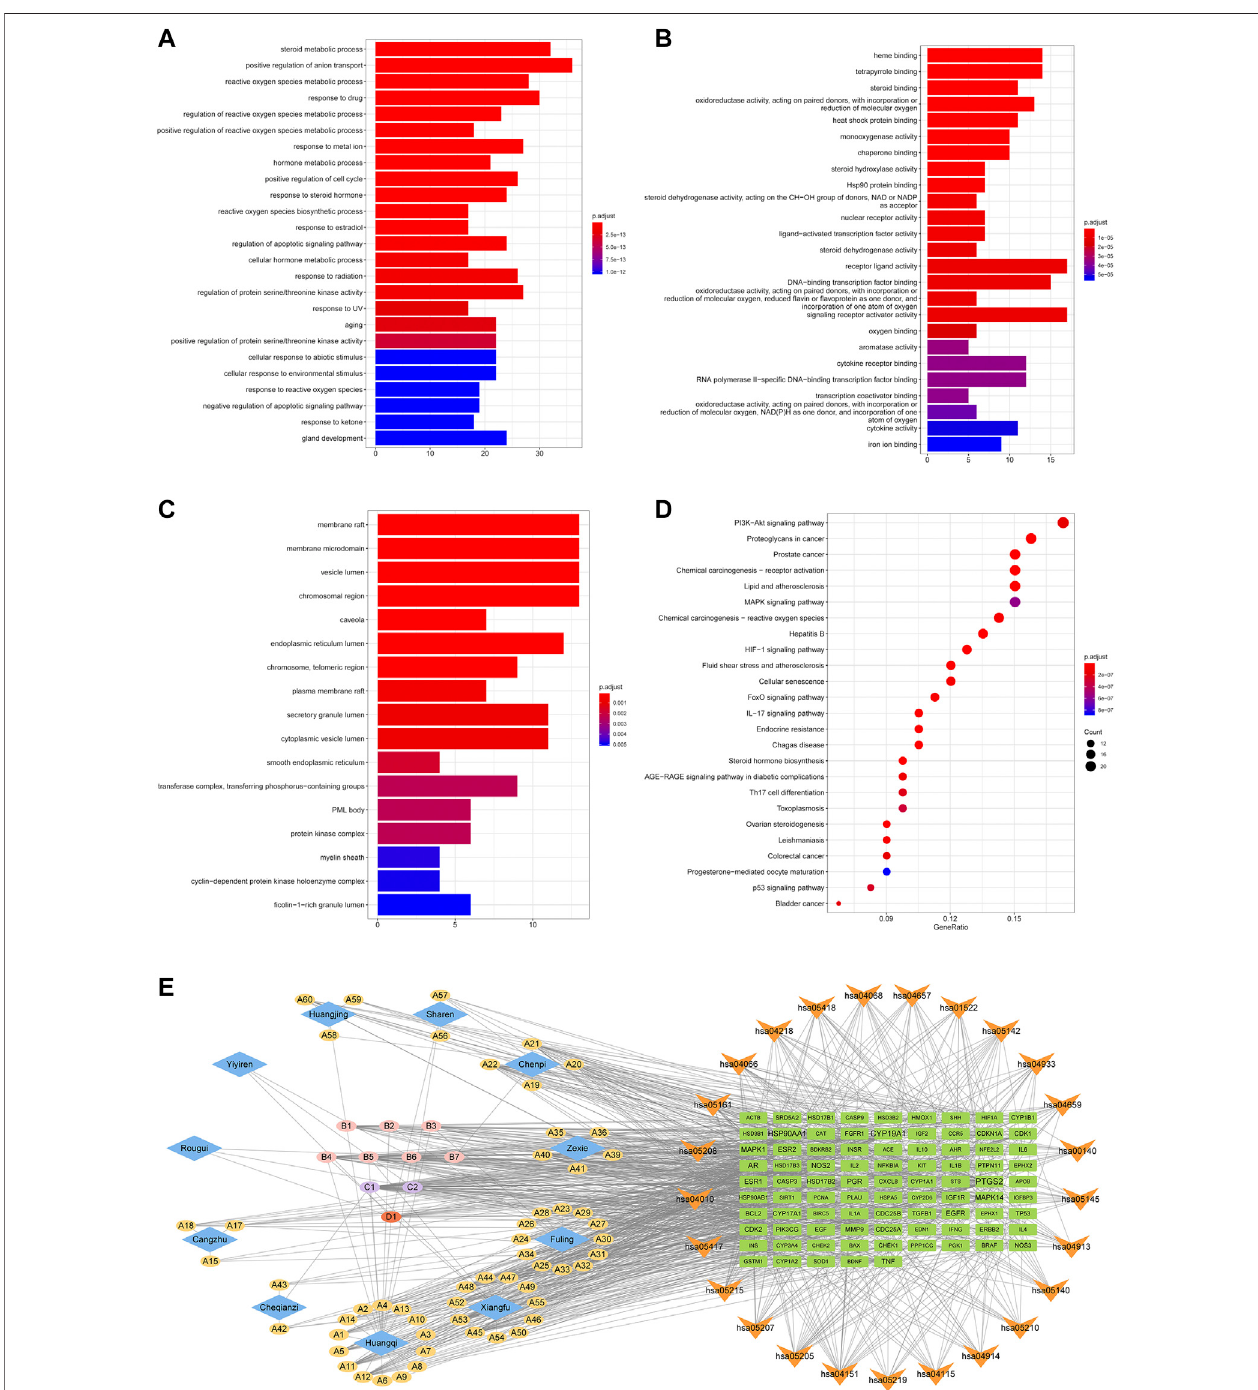
FIGURE5| GOand KEGG pathway enrichmentresults ofH-O-O common targets. (A) Results ofBPenrichmentanalysisfortop 20. (B) ResultsofMFenrichment analysis for top 20. (C) Results of CC enrichment analysis for top 17. (D) The top 25 KEGG pathways enriched by ingredients and corresponding targets. (E) Herb- ingredient-target-pathway (H-I-T-P) network of the HTSJD mechanism for treating O-O. The diamond represents the herbal medicine, the ellipse represents the active ingredient, the square represents the target, and the inverted triangle represents the KEGG pathway. The larger the label size, the larger the degree.